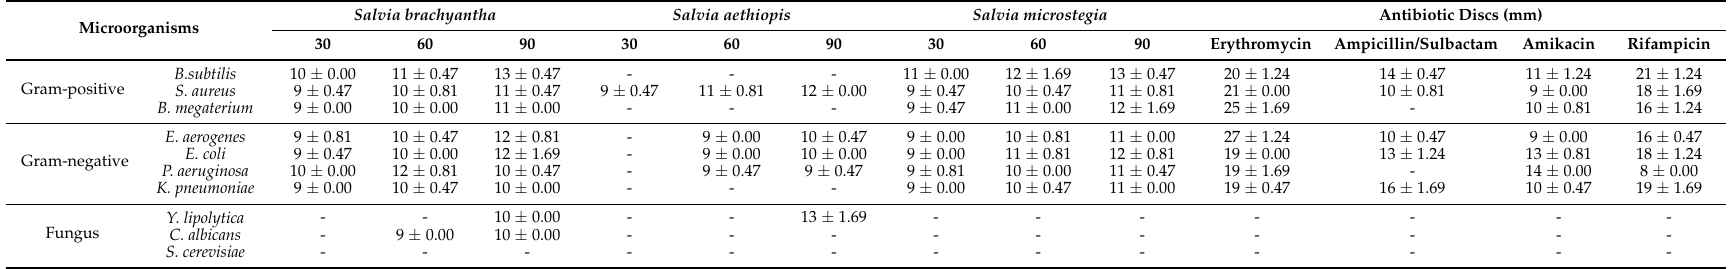
Table 2. Antimicrobial, and antifungal of activities of 20 µ g/mL concentration of Salvia species against different microbial and fungal species (mm zone). Microorganisms